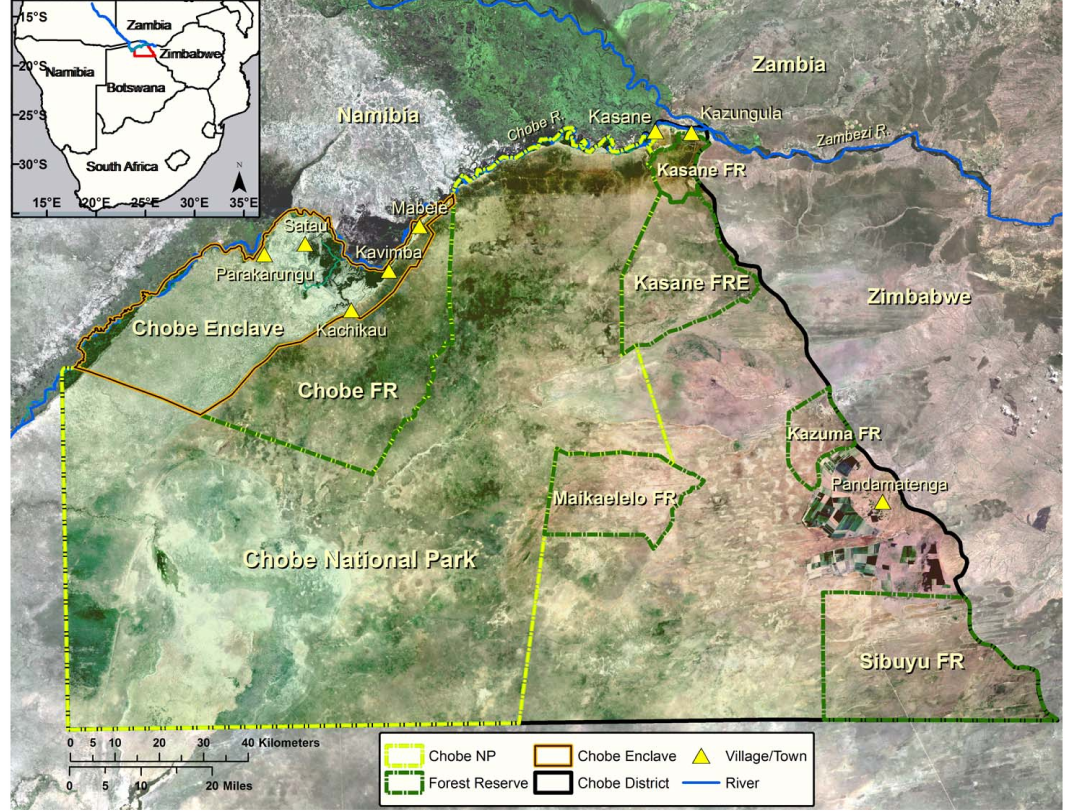
Figure 1. Landsat-based (2013 OLI) map of the Chobe District study area displayed using a natural color (4,3,2) band